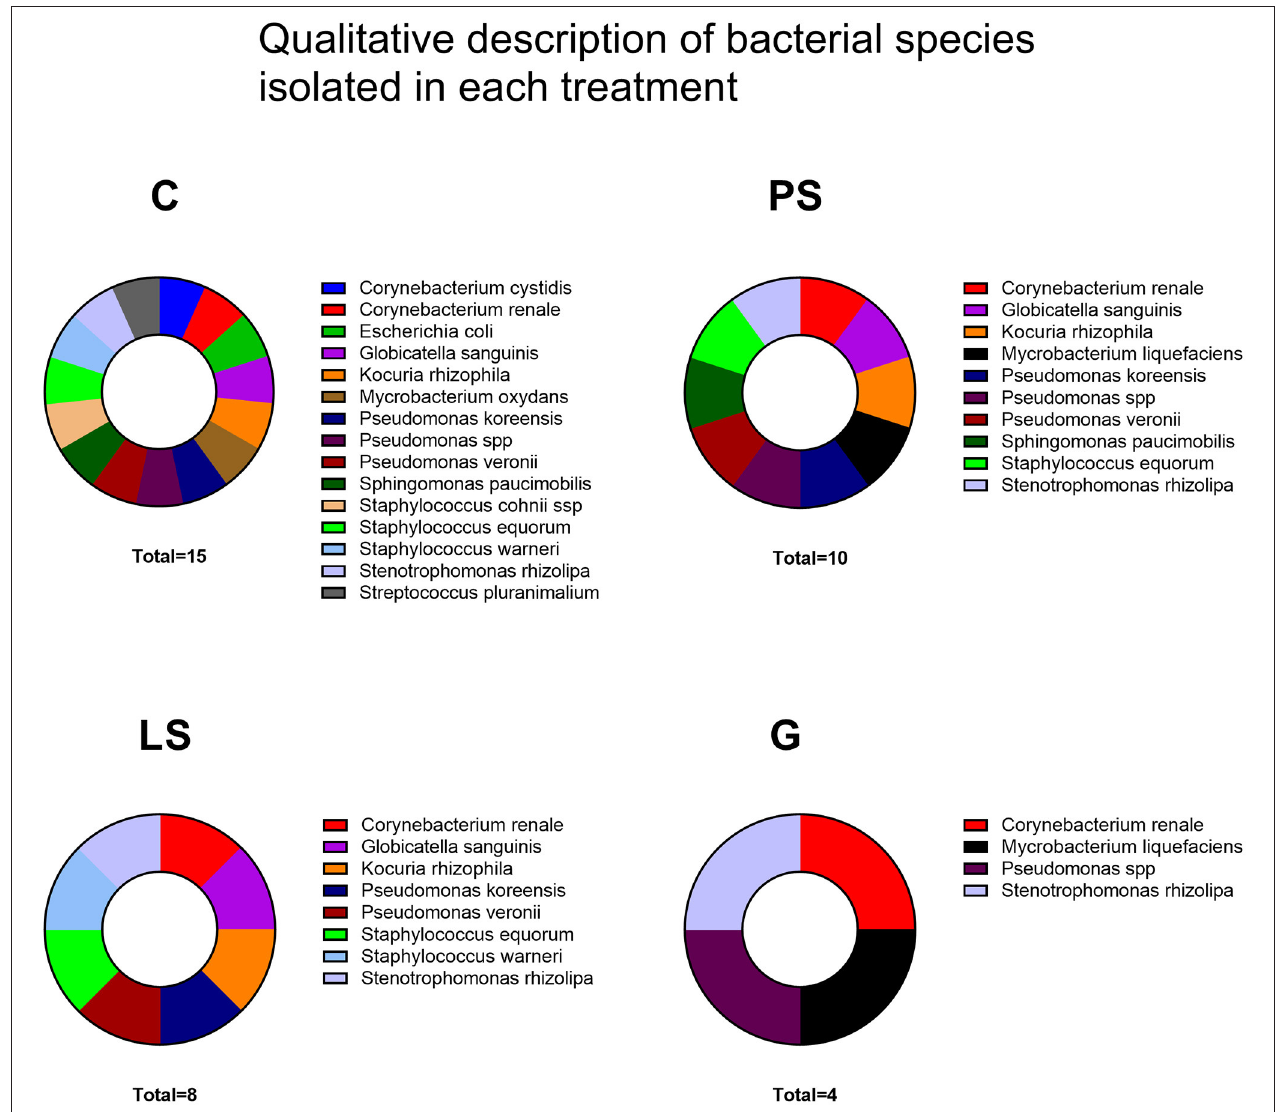
FIGURE 4 | Bacterial species isolated in each treatment after thawing: Control (C), without antibiotics; Penicillin-Streptomycin (PS), (500 UI) − 625 µ g/mL, respectively; Lincomycin-Spectinomycin (LS), 300–600 µ g/mL, respectively; and Gentamicin (G) 1,000 µ g/mL. Eight males were analyzed (1 ejaculate per male) including the same males in each experimental